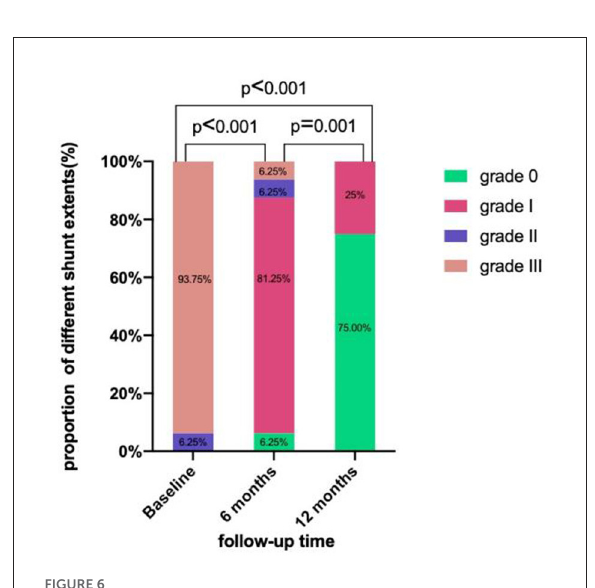
FIGURE6 cTCD showing RLS preoperatively, 6 months, and 12 months postoperatively.